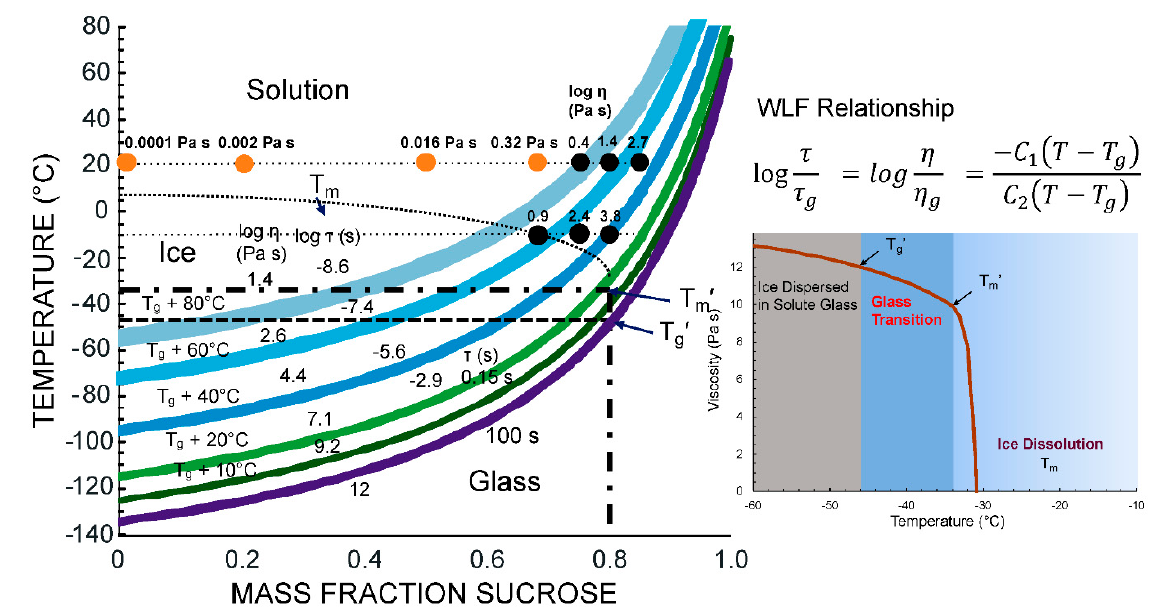
Figure 5. State diagram of sucrose showing physical state and its dependence on temperature and water content. Viscosity data from Longinotti and Corti [28] are shown by closed symbols. The Williams–Landel–Ferry (WLF) relationship [29] was used to estimate structural relaxation times, τ , and viscosity, η , above the calorimetric onset glass transition with corresponding τ g = 100 s and η g = 10 12 Pa s [30]. Parallel curves indicating structural relaxation times with corresponding isoviscous states are shown for various T–T g conditions. The effect glass transition of the maximally freeze-concentrated solution, T g ′ , and ice melting above the T g ′ corresponding ice melting temperature, T m ′ , is shown in the inset diagram.